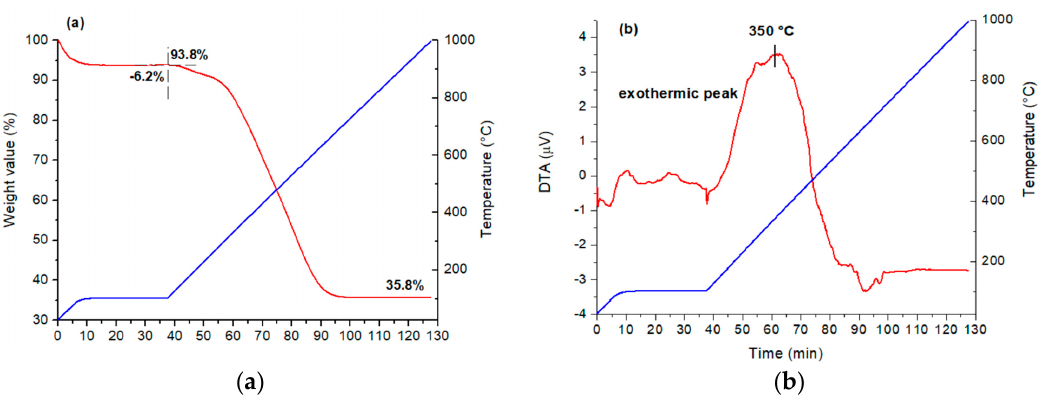
Figure 3. ( a ) Thermogravimetric (TG) and ( b ) Differential thermal analysis (DTA) curves of PolyCat-